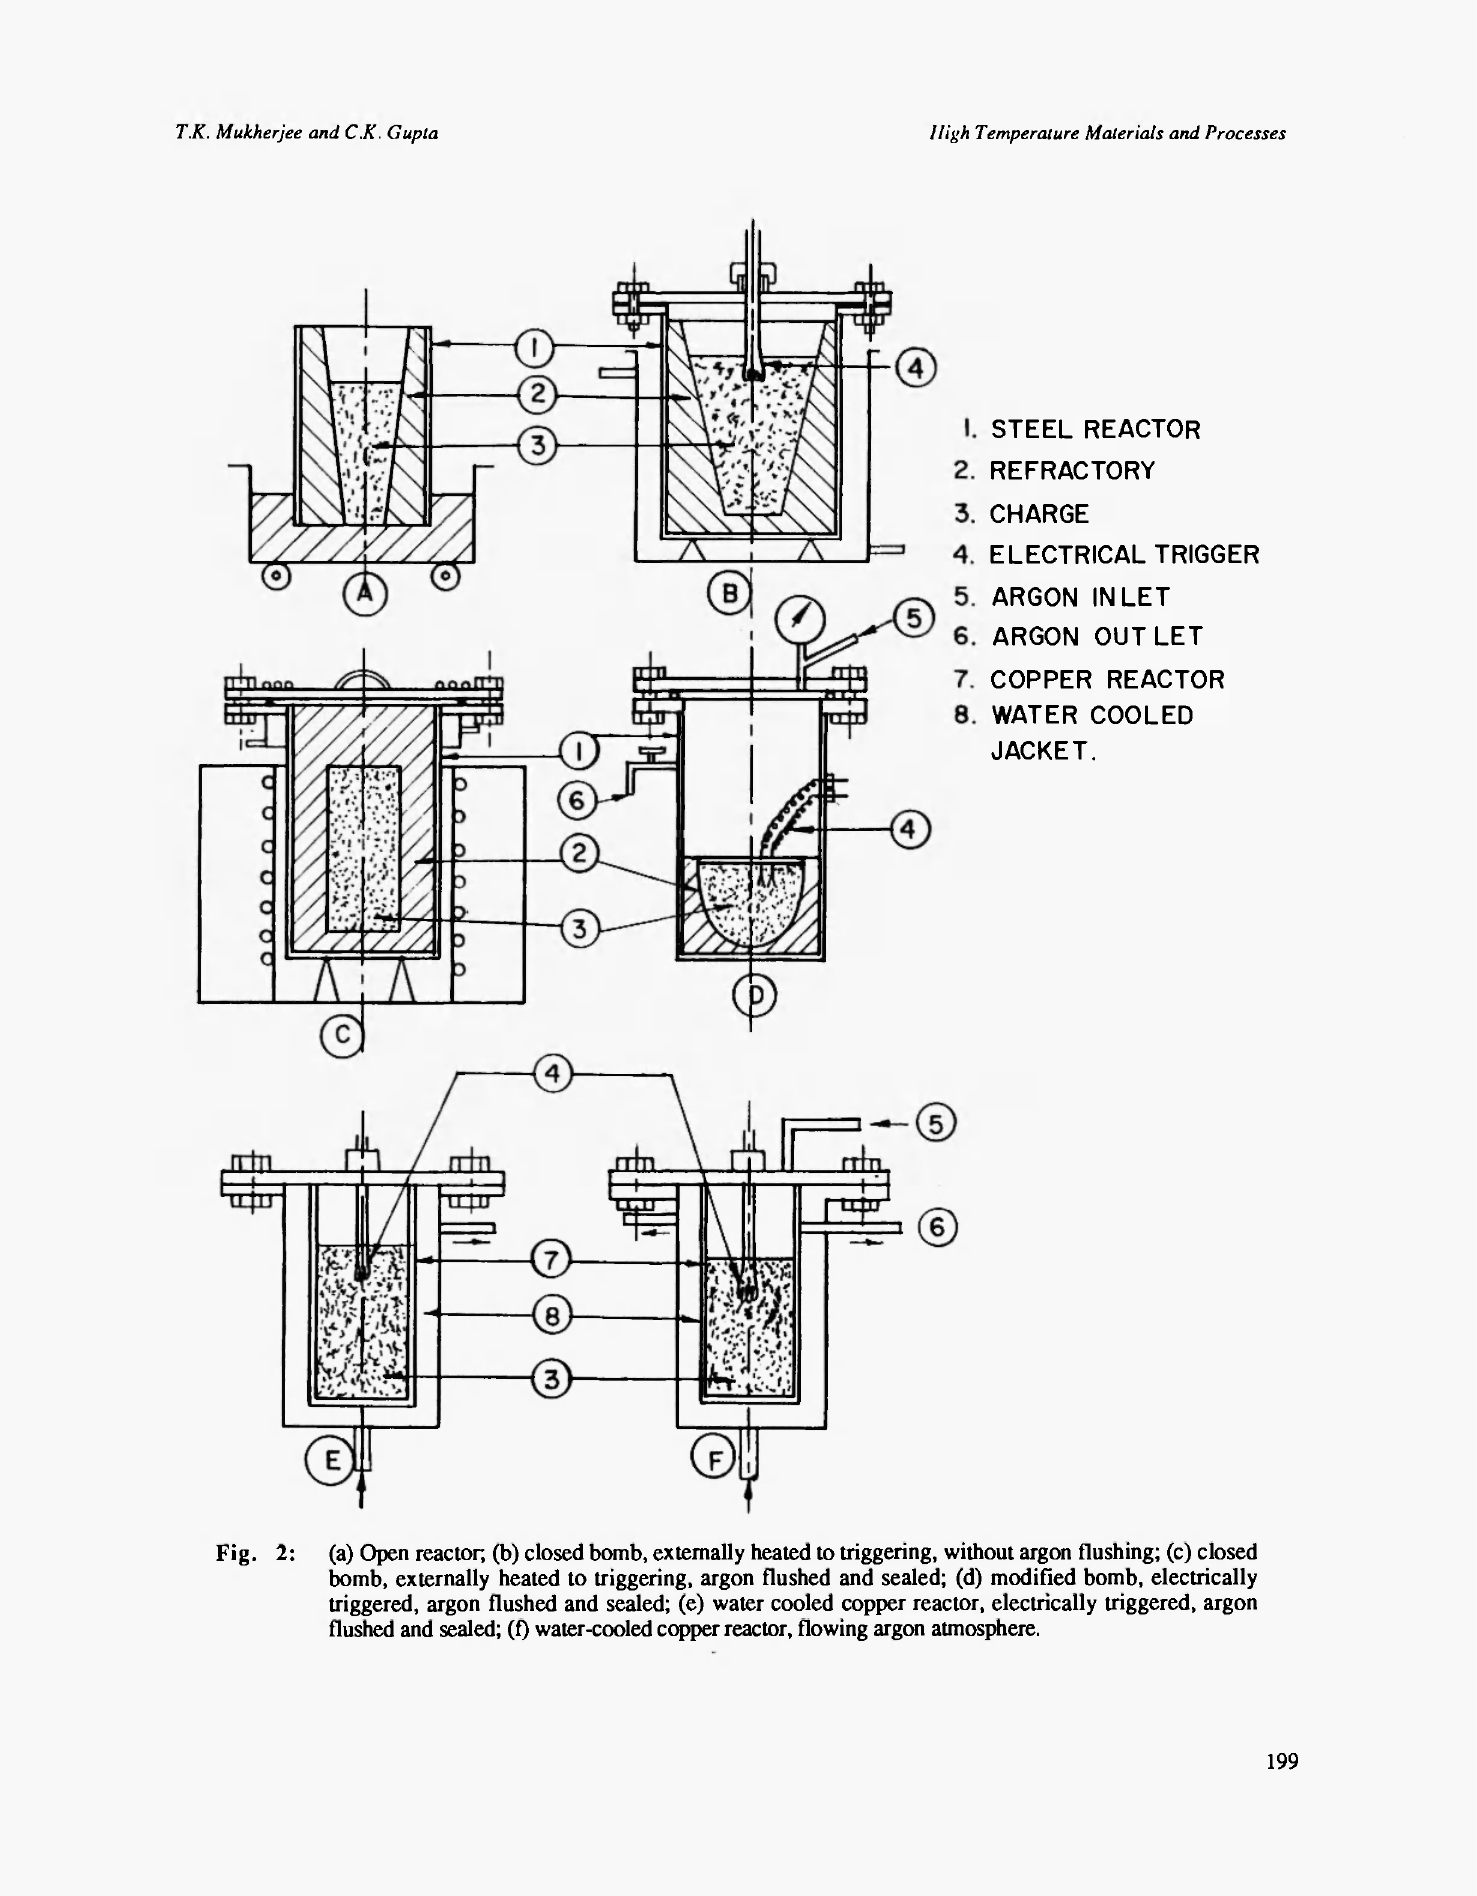
Fig. 2: (a) Open reactor, (b) closed bomb, externally heated to triggering, without argon flushing; (c) closed bomb, externally heated to triggering, argon flushed and sealed; (d) modified bomb, electrically triggered, argon flushed and sealed; (e) water cooled copper reactor, electrically triggered, argon flushed and sealed; (0 water-cooled copper reactor, flowing argon